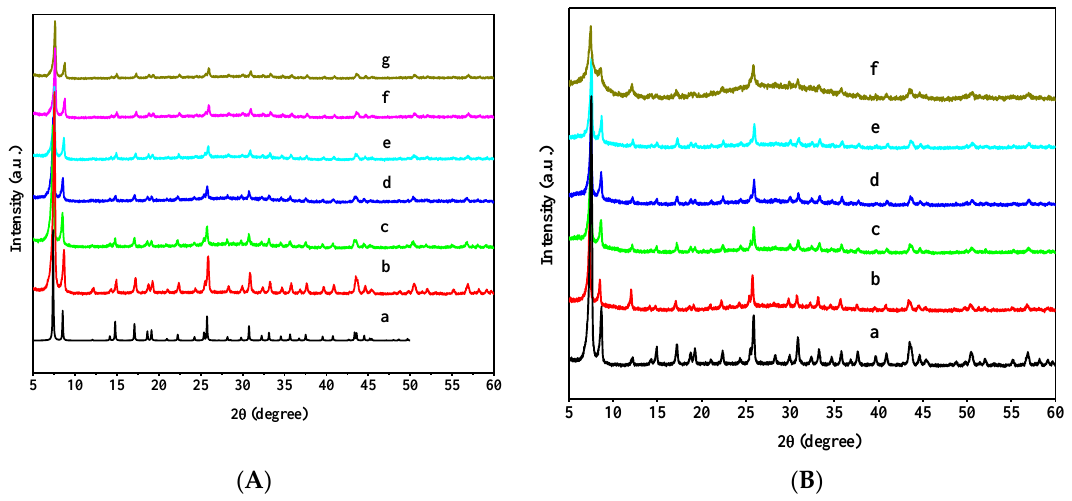
Figure 1. ( A ) X-ray diffraction (XRD) patterns of various samples: (a) UiO-66, reproduced with permission from [37]. American Chemical Society, 2011; (b) UiO-66; (c) 20 wt %; (d) 30 wt %; (e) 35 wt %; (f) 40 wt %; (g) 45 wt % WO 3 /UiO-66; ( B ) XRD patterns of various samples: (a) UiO-66; (b) 5 wt %